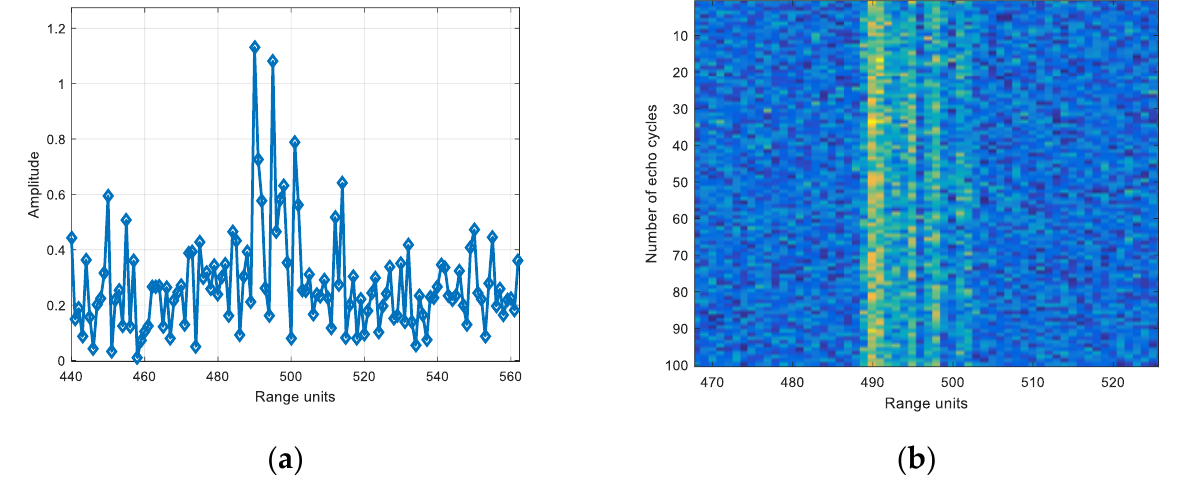
Figure 30. ( a ) Single frame and ( b ) 100 cycles echo diagrams with SNR of 12 dB in wideband.